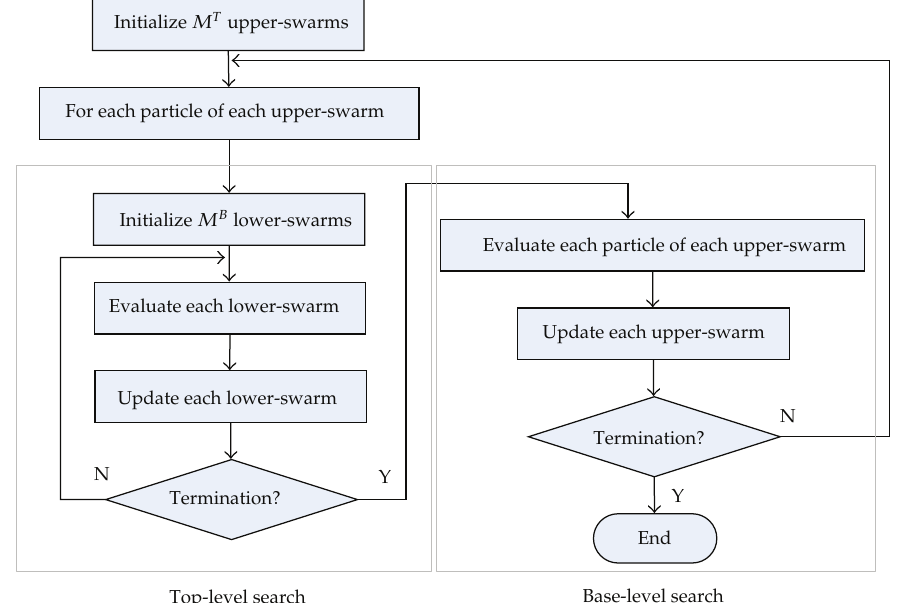
Figure 12: The risk management algorithm based on PS 2